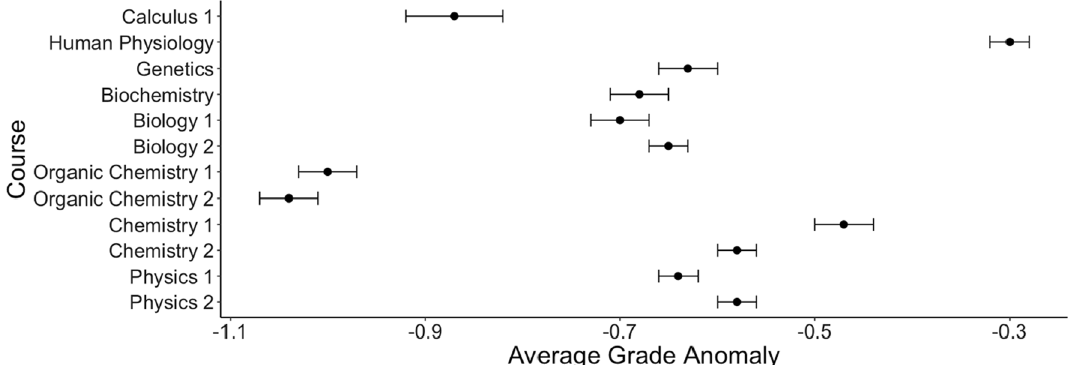
Fig. 1 Average grade anomalies (AGAs) for each course of interest. The error bars represent standard